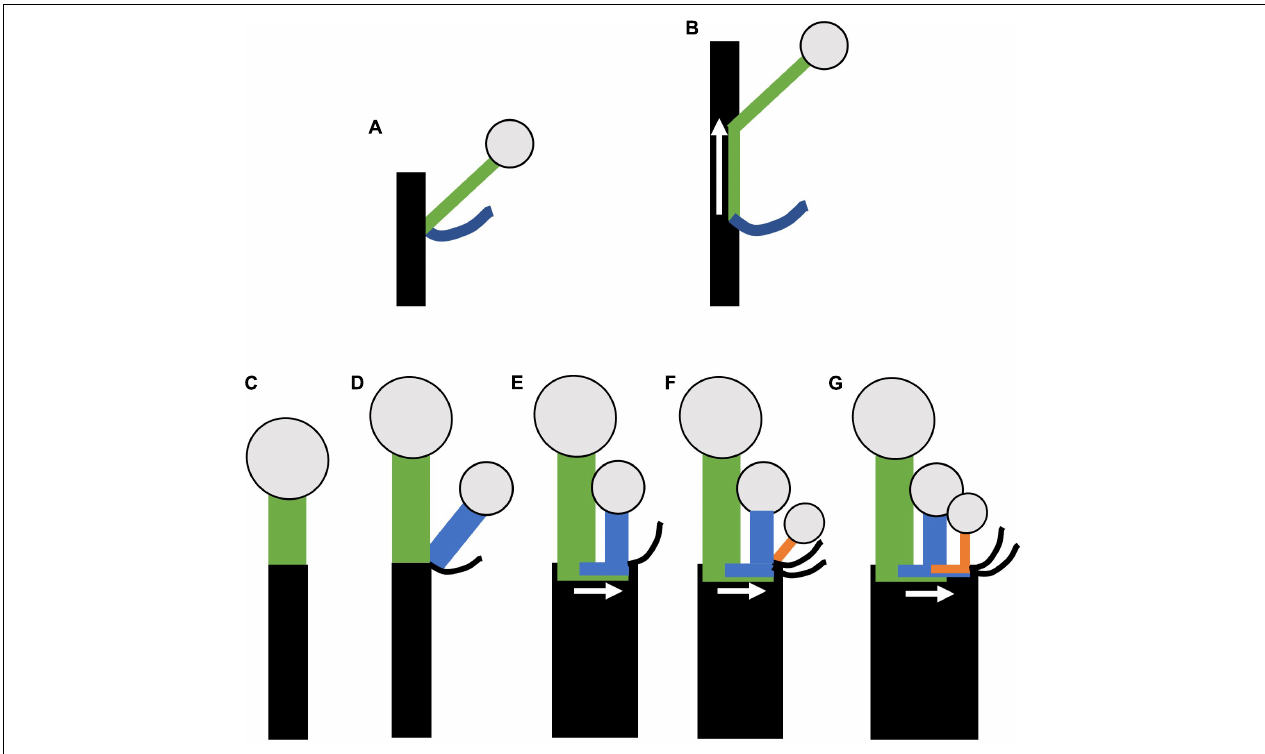
FIGURE 13 | Model of horizontal concaulescence. (A,B) Concaulescence following Weberling (1992) (A) Typical lateral (axillary) branching. (B) Concaulescence ; lateral branch is congenitally fused (note overlap of green with black) to the main stem and displaced vertically relative to the subtending bract. (C–G) Horizontal concaulescence exemplified in a single cymose branch with two sequential branching events (D,F) . (C) Stem with terminal flower, inflorescence bract not shown. (D) Lateral (axillary) branching event (blue). (E) Secondary displacement of the lateral branch (blue) such that the pedicel is horizontally adjacent to the terminal flower. (F) A second branching event (orange). (G) Secondary displacement of the lateral branch as in (E) . Rectangles = stems; Circles = terminal flowers; black curved lines = bracts; arrow = direction of concaulescent